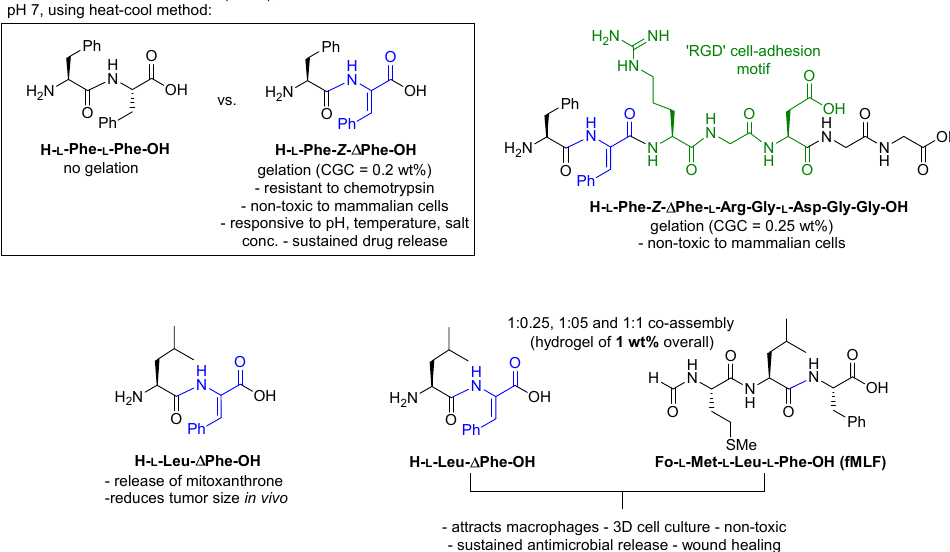
Figure 4. Summary of uncapped short dehydropeptides capable of forming hydrogels.